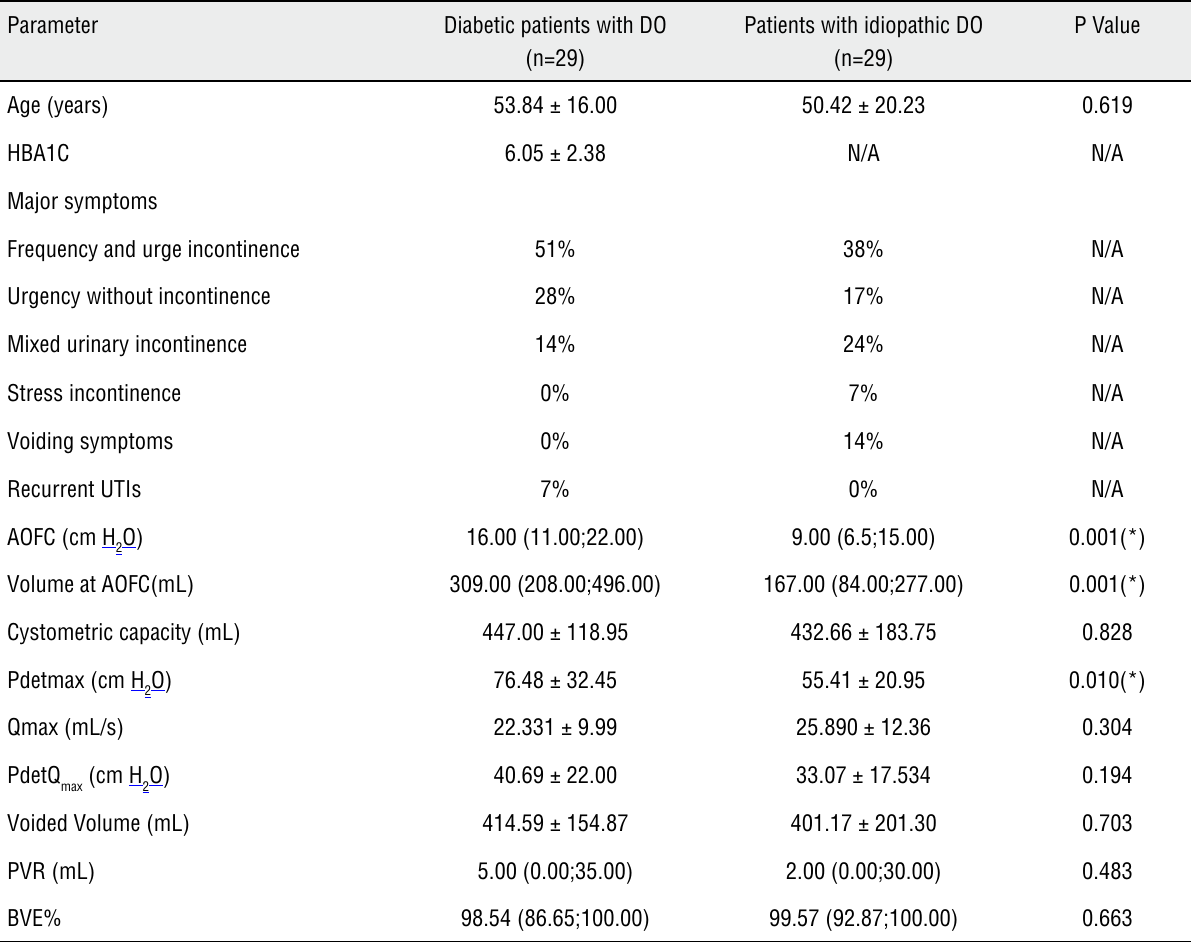
Table 1 - Characteristics of the groups and comparison of urodynamic parameters and index of bladder voiding function in diabetic patients with dO and